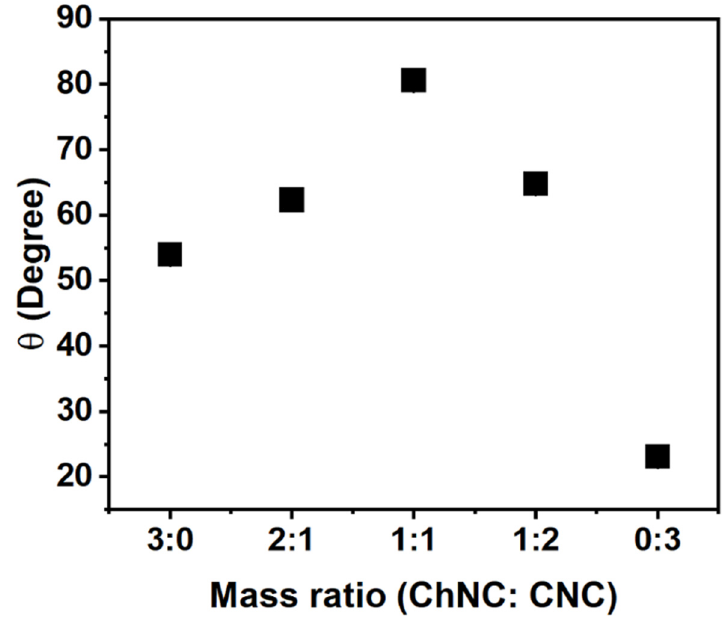
Figure 6. Contact angle of a 20 mM NaCl solution on nanocrystal films submerged in soybean oil as a function of ChNC:CNC mass ratio, indicating a maximum contact angle at a 1:1 mass ratio. The result provides evidence of a preferential exposure of hydrophobic planes when both nanoparticles are combined. The error bars are smaller than the markers; the standard deviations are, from left to right: 0.65 ° , 0.18 ° , 0.79 ° , 0.34 ° , and 0.43 ° .